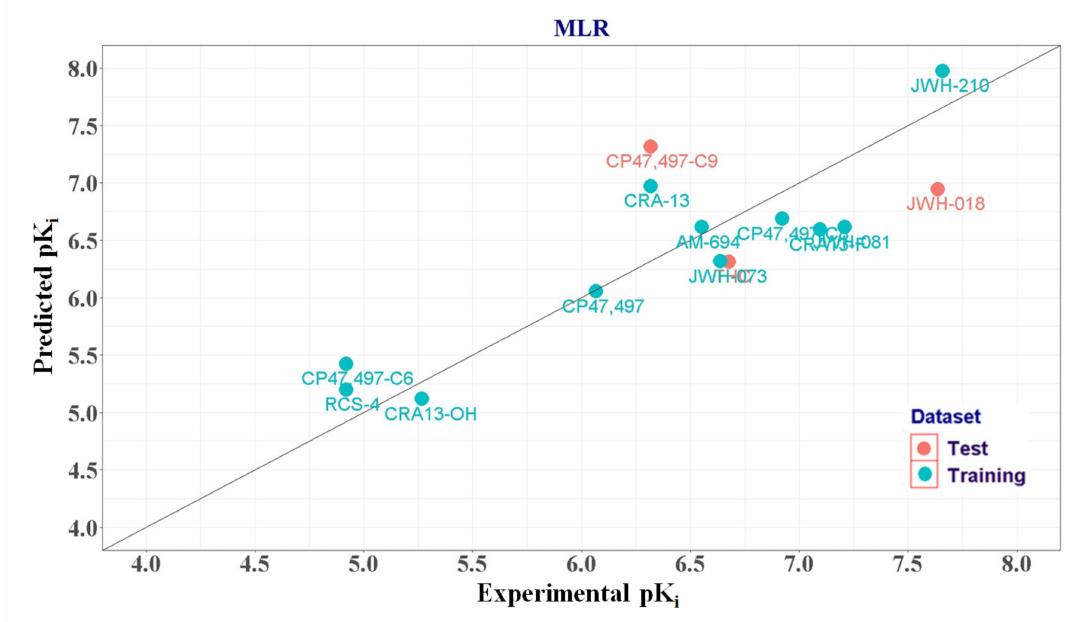
Figure 6. Plot of predicted versus experimental pK i values of multiple linear regression model 31.